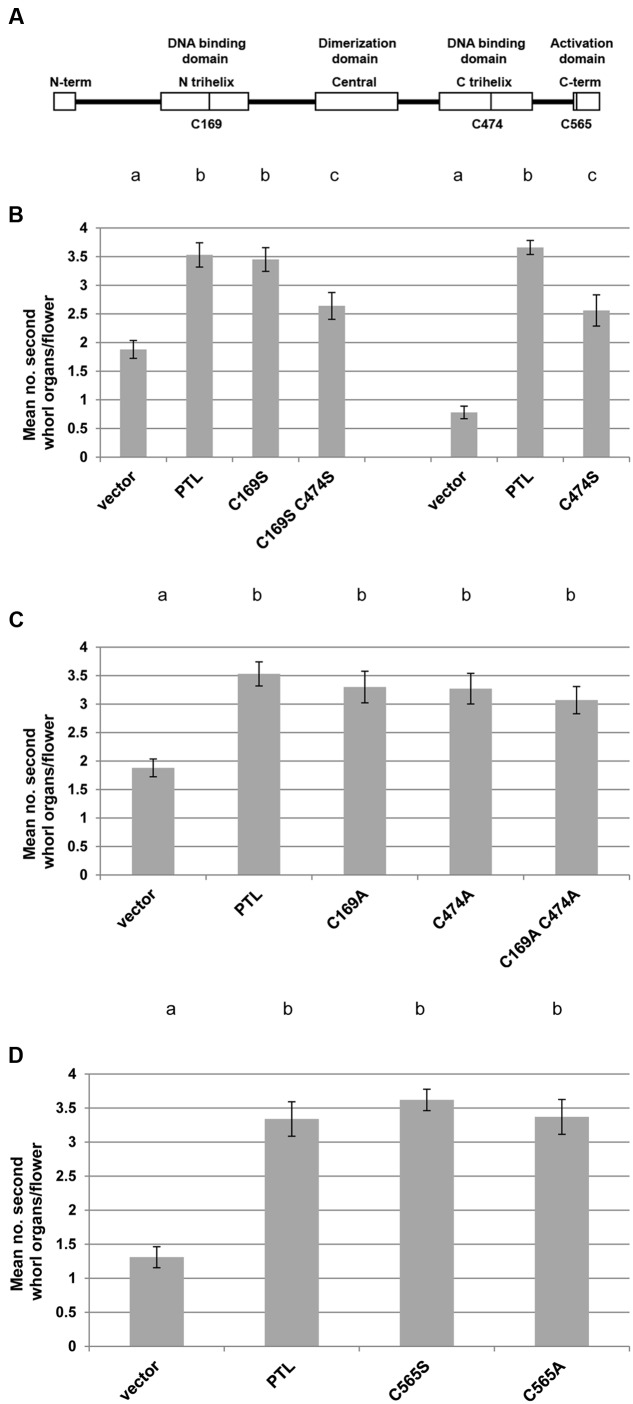
Complementation tests of second whorl organ numbers in ptl-1 mutant plants transformed with PTL transgenes carrying cysteine mutations.
(A) Sites of three conserved cysteines in the PTL protein that were mutated to either serine or alanine. (B–D) Mean number of second whorl organs per flower in ptl-1 T1 plants transformed with PTL [pPTL(1.3i):2A-GUS-2A-PTL] following site-directed mutagenesis. Negative controls were T1 plants transformed with the empty vector, and positive controls were plants transformed with the wild type PTL. Comparisons were made within individual experiments except for serine mutations of the cysteines in the two DNA binding domains (C169 and C474) which were tested in two separate experiments, with relevant controls in each case (B). Individual data for the 12–15 T1 plants scored for each treatment are provided in Supplementary Figure S5. Bars represent SEM. Pairwise comparisons by t-tests were carried out. Observations that were not significantly different (p > 0.05) are indicated by the same letter at the top of each column within experiments. All other comparisons within experiments were significantly different (p < 0.01).